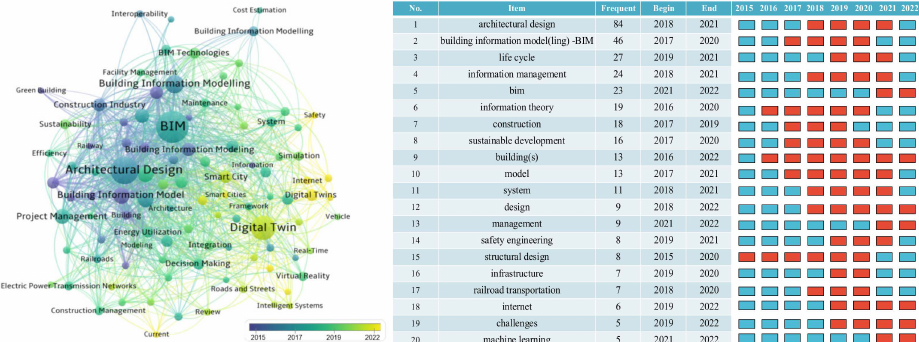
Figure 6. Keyword Collaborations from 2015–2022 and the Evolution of TOP 20